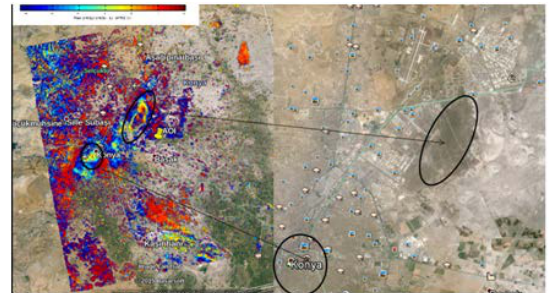
Figure 5. ALOS PALSAR DInSAR results from 608 track - 740 frame (2008/02/12-2006/09/24 ifg - 480 days)